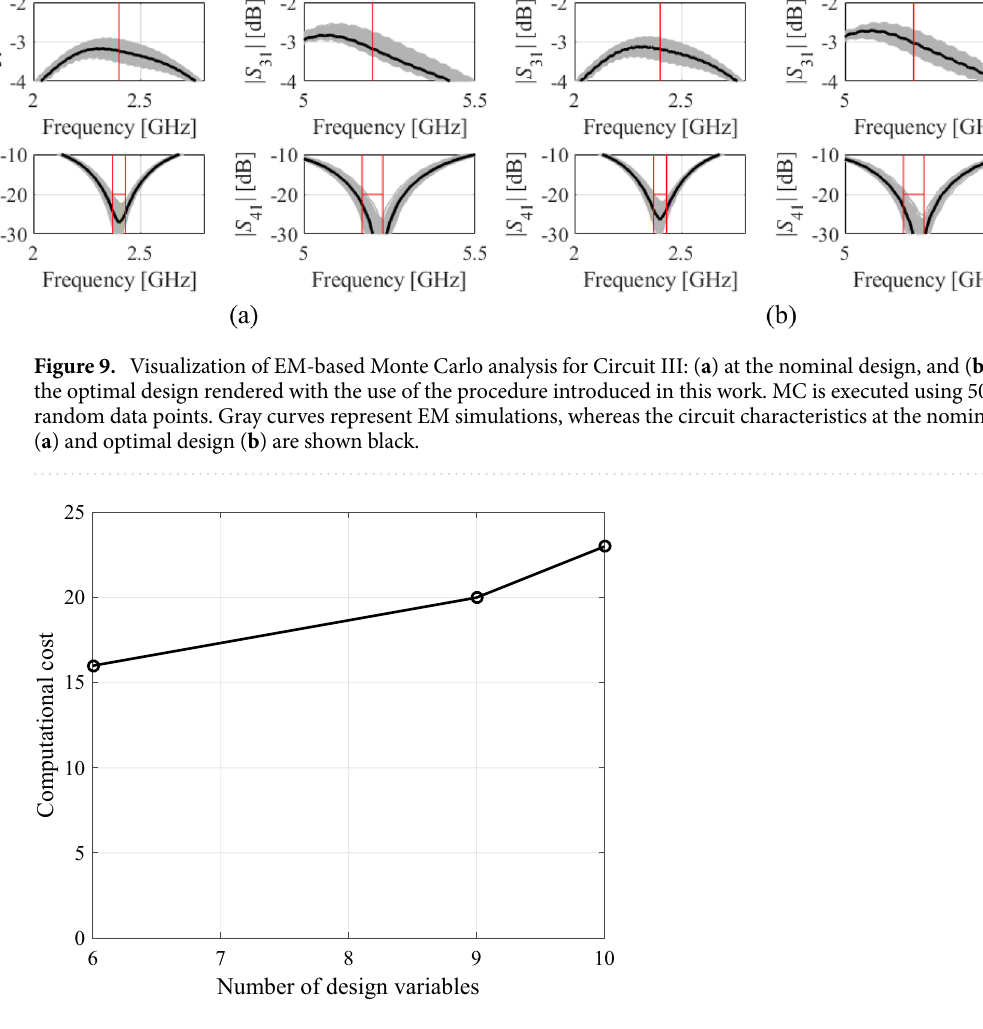
Figure 10. Computational cost of the yield optimization process using the proposed algorithm versus number of design variables for Circuit I, III, and II described by 6, 9, and 10 design